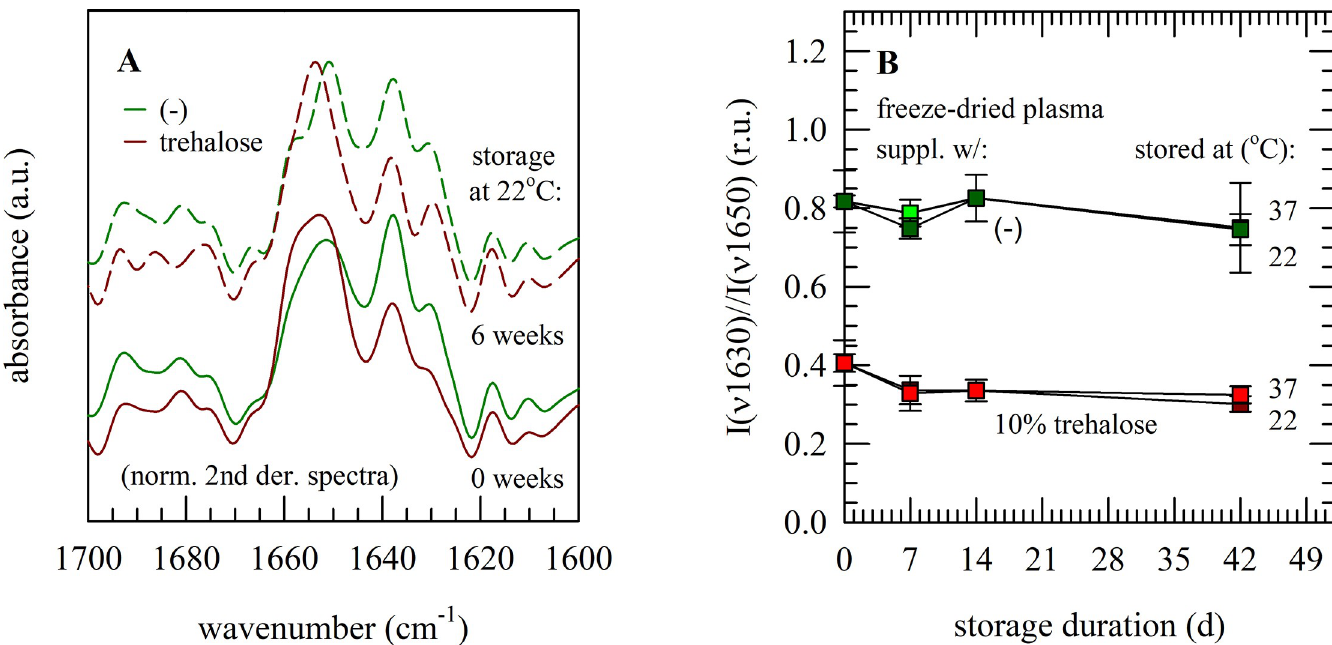
Fig 5. Infrared spectroscopic analysis of freeze-dried plasma during storage. Storage-related changes in infrared spectra of plasma freeze-dried without protectants (green) or with 10% trehalose (red). Spectra were acquired immediately after freeze-drying (solid lines) as well as 6 weeks storage (dashed lines) at 22˚C; and normalized second derivative spectra were calculated for the 1700 − 1600 cm − 1 region (A). The ratio between the band intensities at ~1630 and ~1650 cm –1 , representing respectively α -helical and β -sheet structures, was calculated to reveal changes in the protein secondary structure during storage at 22 or 37˚C (B). Mean values ± standard deviations were calculated from three replicates/measurements performed using plasma from three different donors.